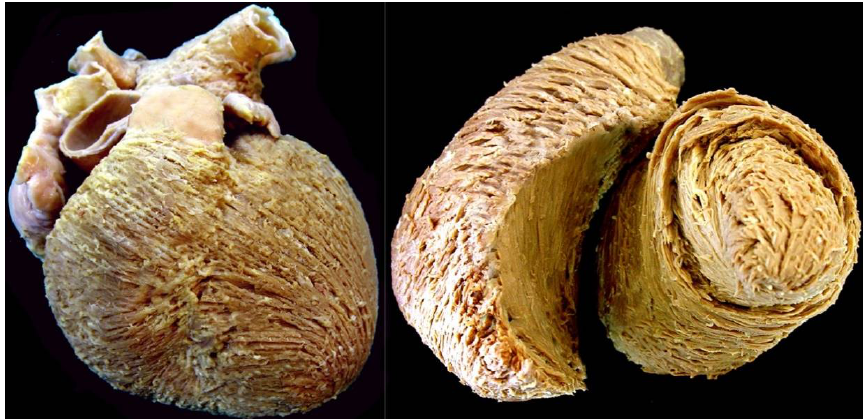
Figure 3. The dissection shown in the ( left hand ) panel was made by removing or ‘peeling’ the epicardial covering of the ventricular cone. It shows the obvious “grain” produced by the aggregation of the cardiomyocytes into chains. Note that the superficial cardiomyocytes are shared between the ventricles, with no traceable division. The left ventricular chains show a marked angle relative to the ventricular long axis. The image shown in the ( right hand ) panel demonstrates that the cardiomyocytes in the left ventricular mid-wall are aggregated in circumferential fashion. It was such studies using gross dissection that formed the basis of the monumental studies of Pettigrew. Based on his dissections, Pettigrew had already determined that it was inappropriate to